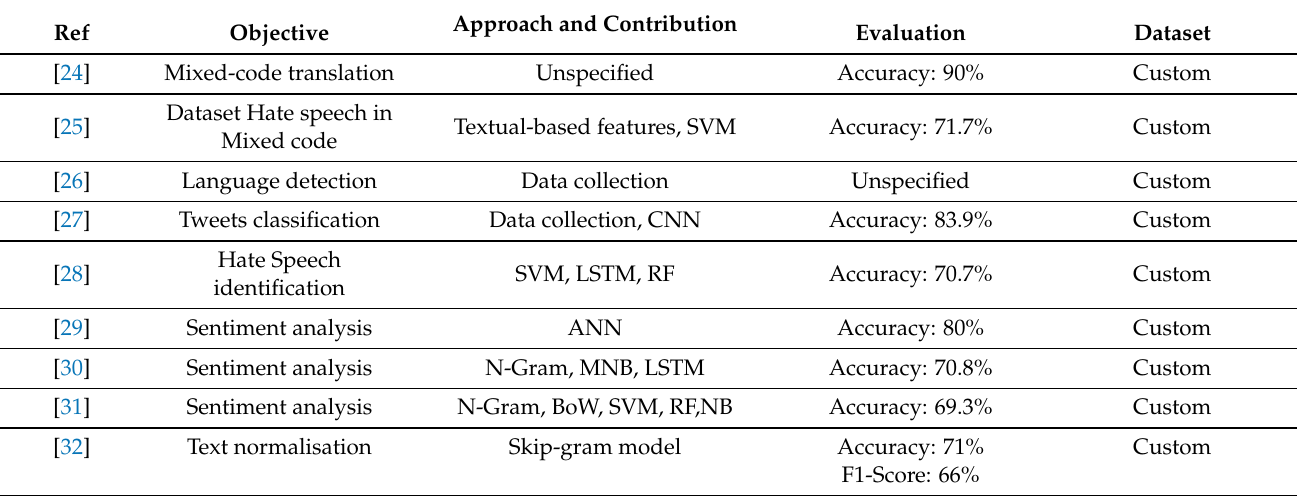
Table 1. Mixed code related